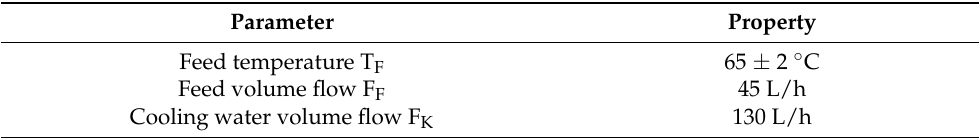
Table 6. Operating conditions prior to microbiological